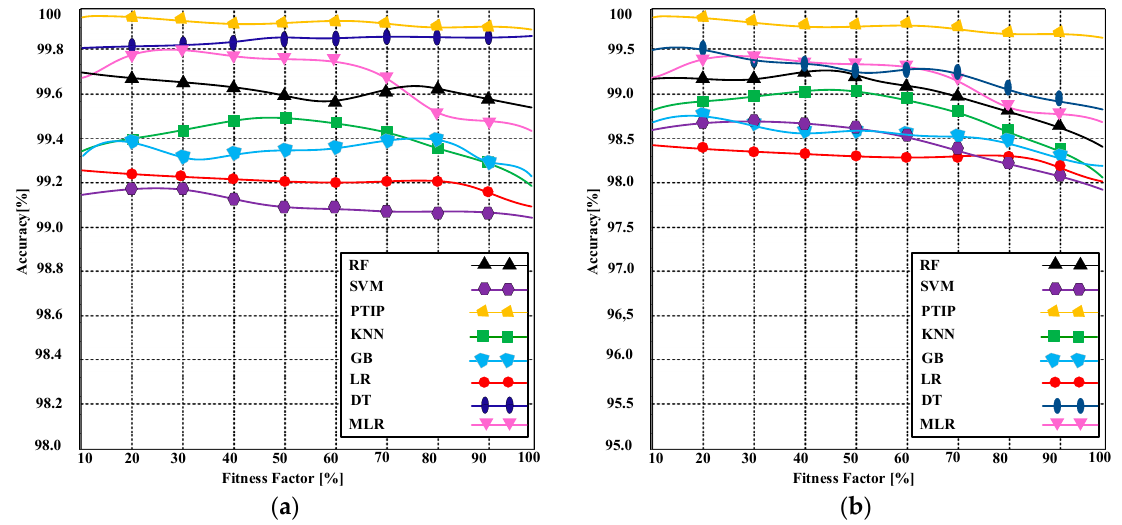
Figure 10. ( a ) Comparison of PTIP with existing algorithms based on correlation accuracy with fitness factor with 200 data samples; and ( b ) Comparison of PTIP with existing algorithms based on correlation accuracy with fitness factor with 300+ data samples .